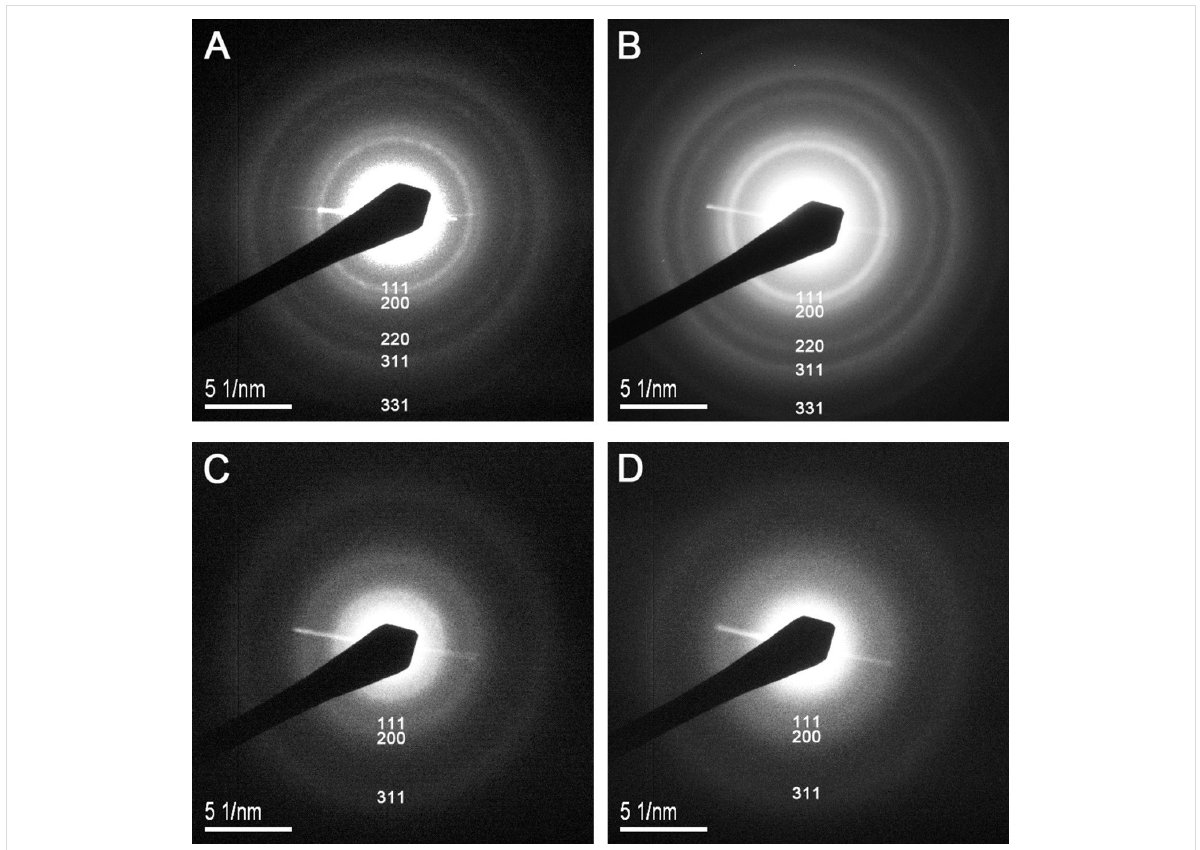
Figure 4: SAED patterns of the sequential size-selected fractions (A) F 36% , (B) F 54% , (C) F 7 2 % , and (D) F 90% .